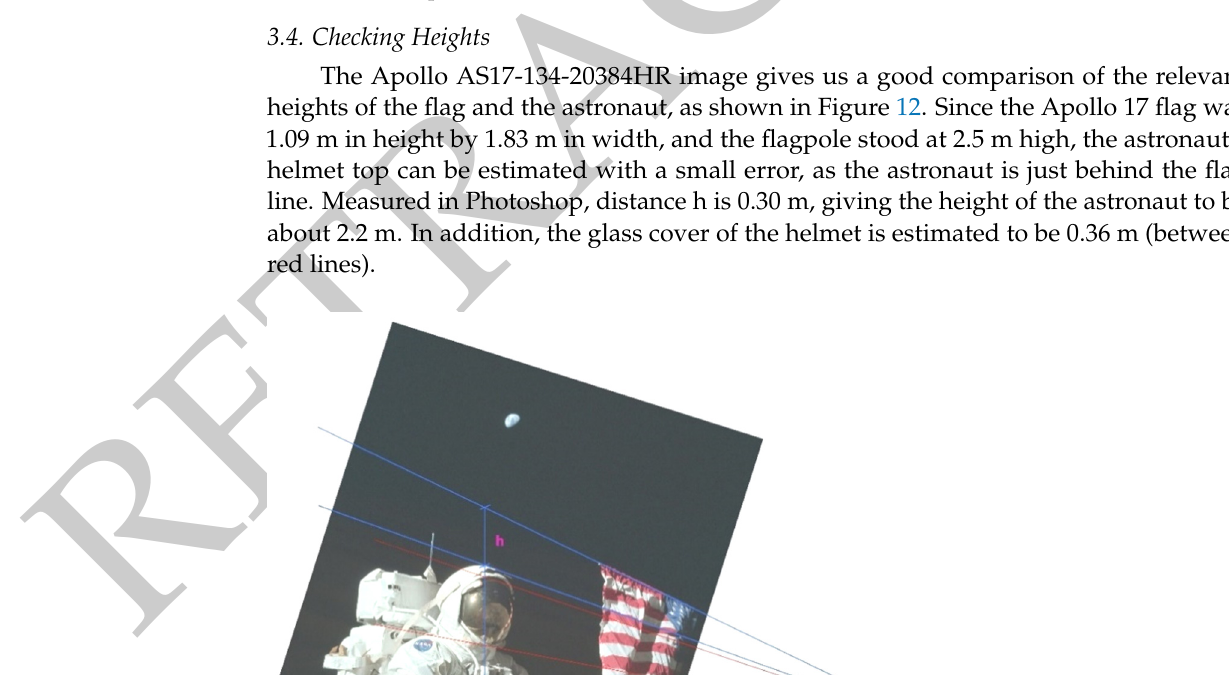
Figure 11. Flag imaged in photos AS17-134-20386 and AS17-140-21391. Since the flag’s height is 1.09 m, then the pole is about 2.50 m tall.